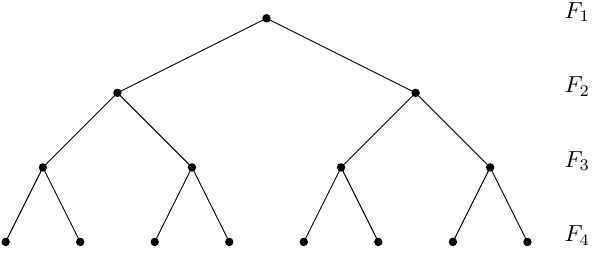
Figure 6. A 4-level exponentially split cluster formation